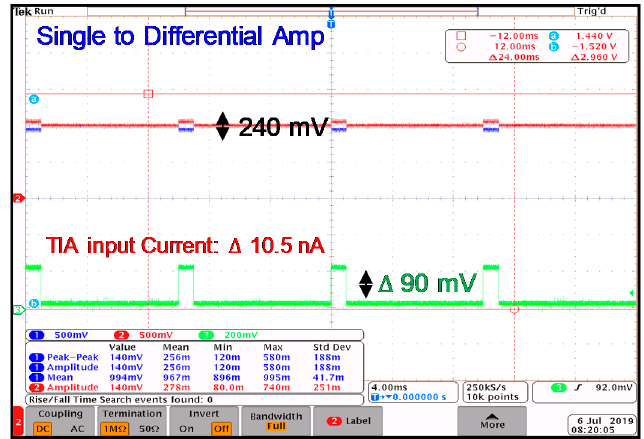
Figure 16. The measured output of the SDA.